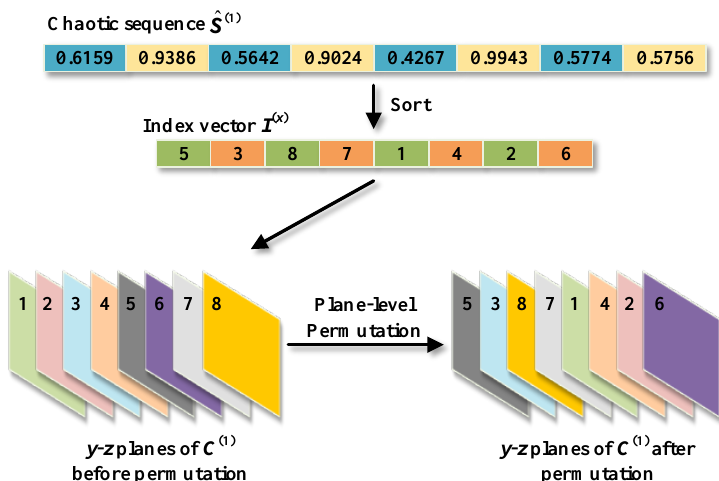
Figure 3. Plane-level permutation of IEA-IF-DLT along x